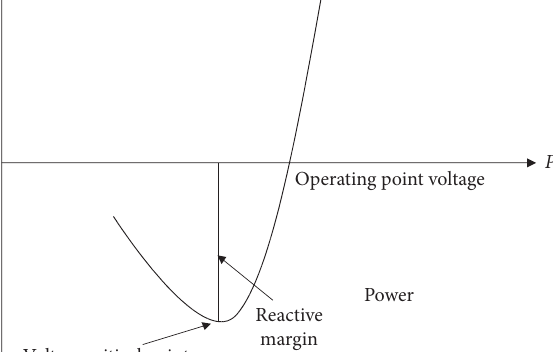
Figure 1: PV curve.